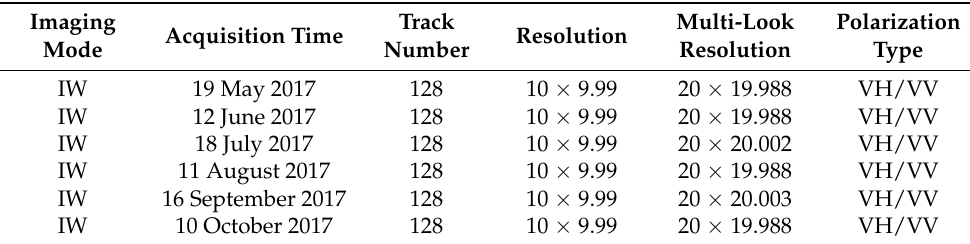
Table 2. Sentinel-1A data.